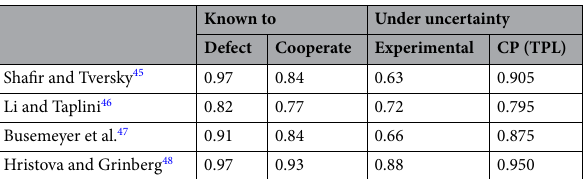
Figure 1. An example of the payoff matrix and classical Bayesian network for the prisoner’s dilemma game. Each node is related to a prisoner. The conditional probabilities are presented in related tables in this structure. Known to Under uncertainty Defect Cooperate Experimental CP